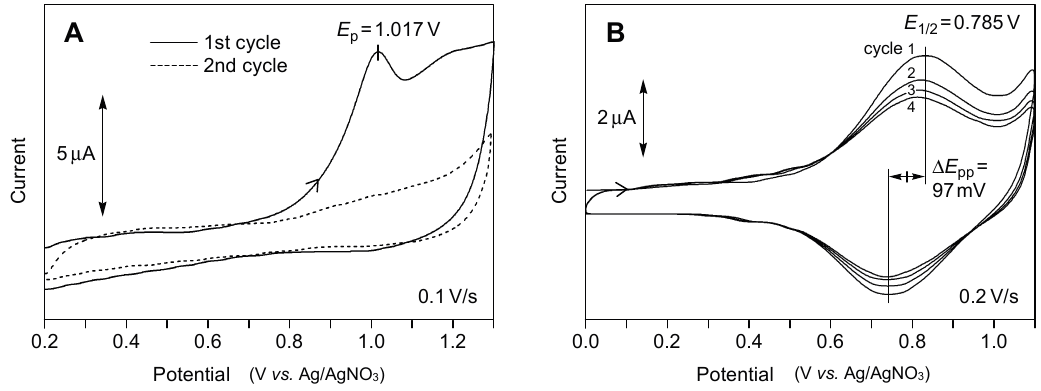
Figure 6. Cyclic voltammograms of the SAMs of 3a ( A ) and 3b ( B ) recorded in CH 2 Cl 2 : geometric area of the working electrode, 0.152 cm 2 ; scan rate, 0.1 V·s − 1 for 3a and 0.2 V·s − 1 for 3b . Tetrabutylammonium perchlorate (TBAP) (0.1 M) was used as a supporting